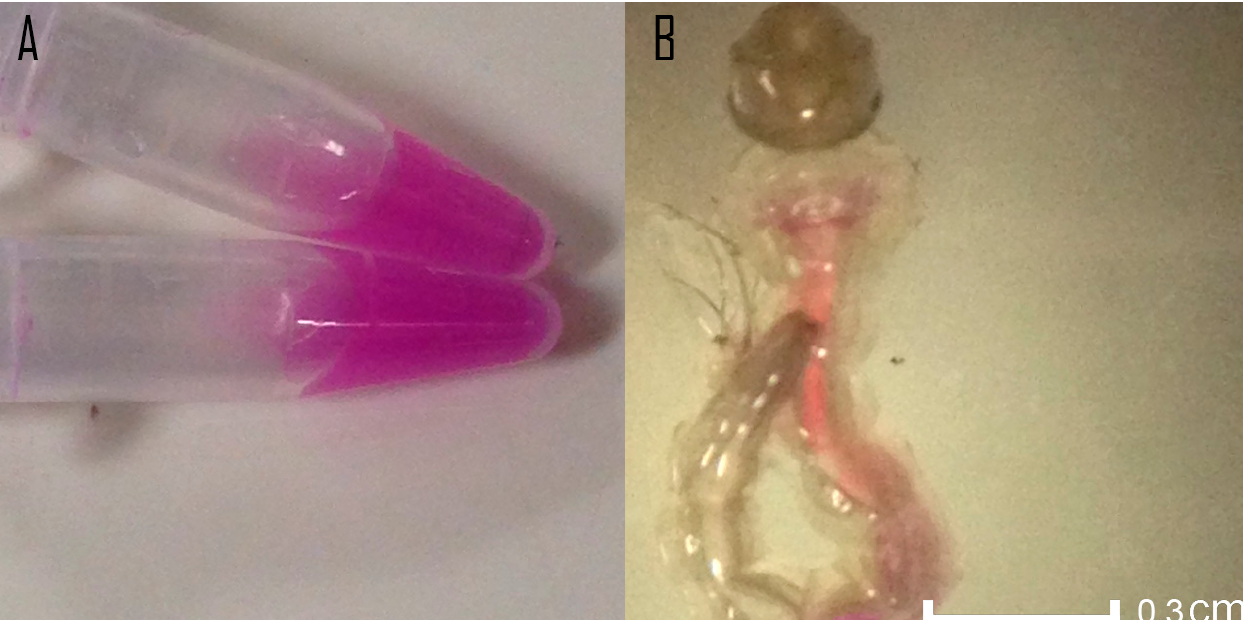
Figure 1. ( A ) Modified E. coli expressing the red fluorescent protein (mRFP) after being exposed to antibiotic. ( B ) Colouration observed within the larvae’s digestive tract after the ingestion of modified E. coli expressing mRFP.